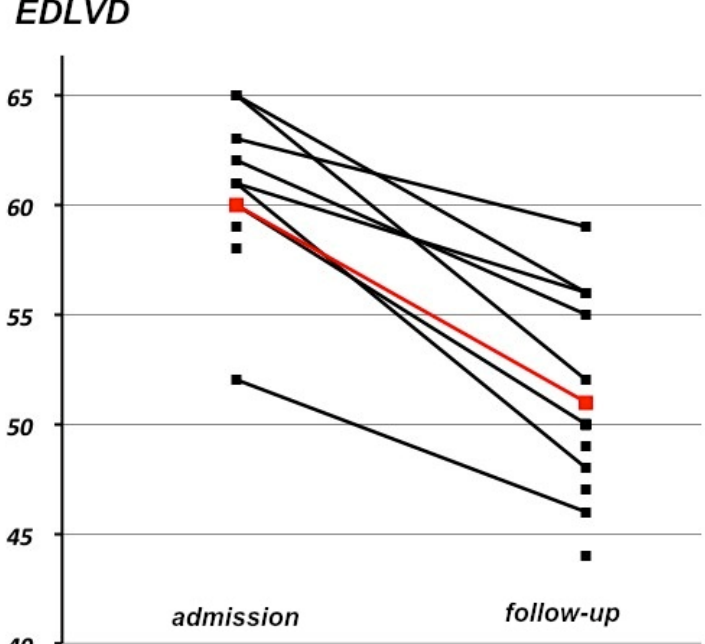
Figure 3. Evolution of EDLVD between admission and follow-up (red = mean).